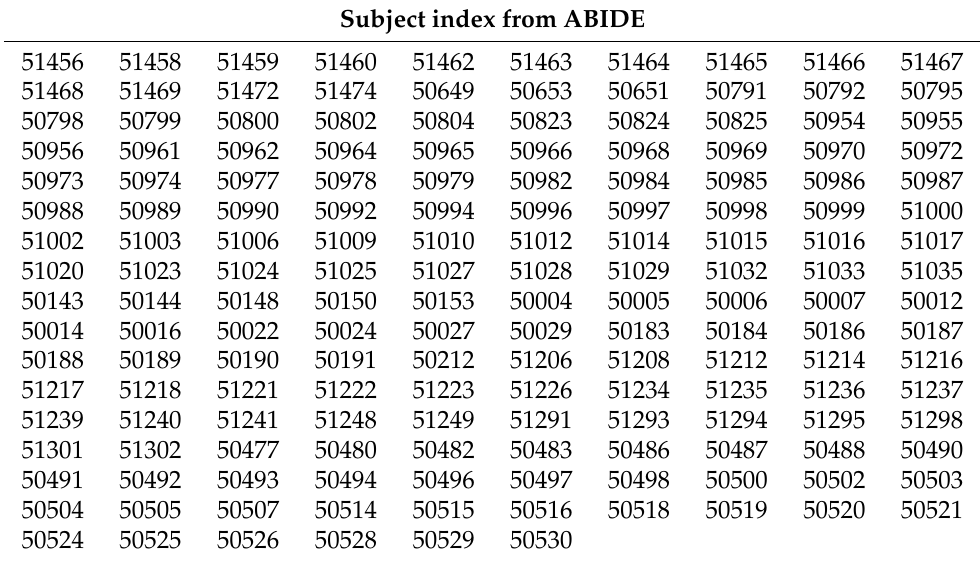
Table 4. Autistic subjects group.